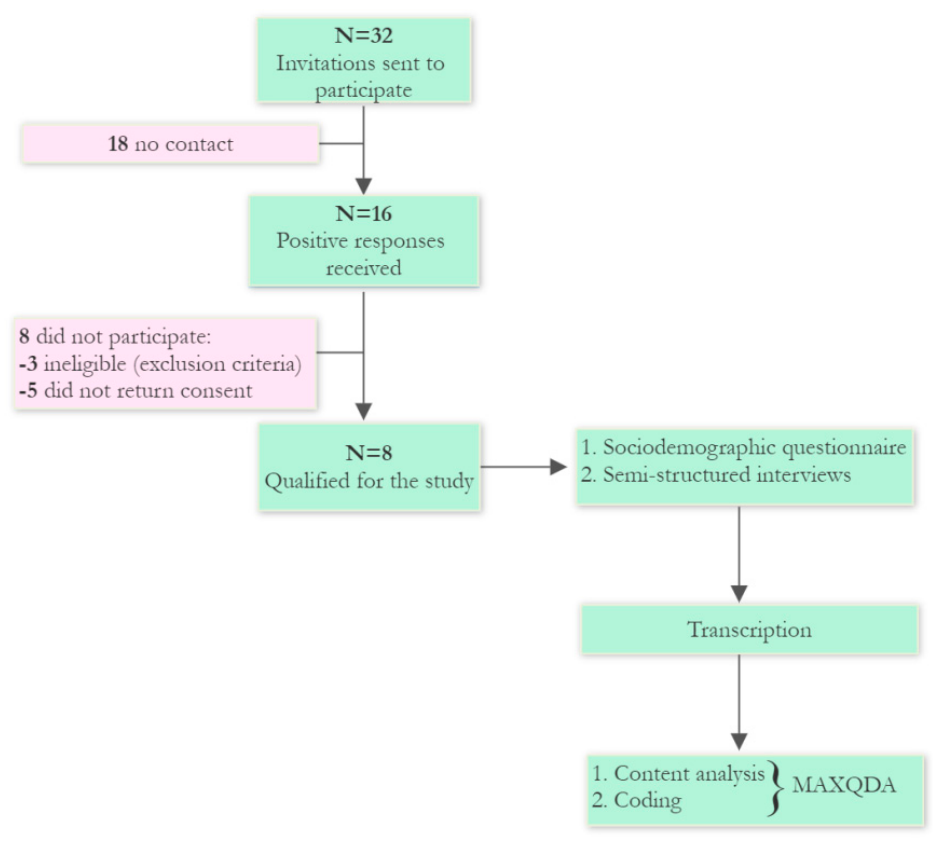
Figure 1. The flow chart of the study design.